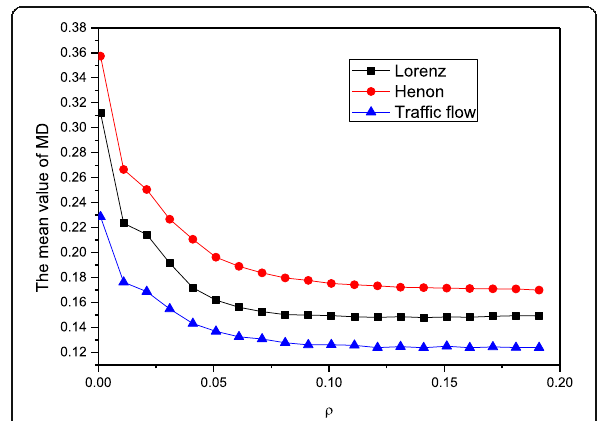
Fig. 6 The MD mean value of second group chaotic signals ’ surrogate data. The curve trends of two groups of chaotic signals are highly consistent